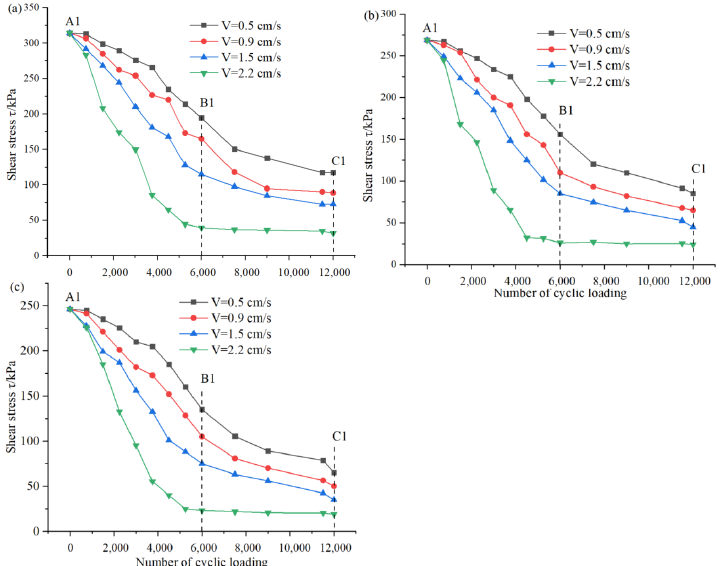
Figure 7. Evolutions of shear stress of slip zone soil under different cycle loading in ( a ) confining pressure = 200 kPa, ( b ) confining pressure = 100 kPa, ( c ) confining pressure = 50 kPa.